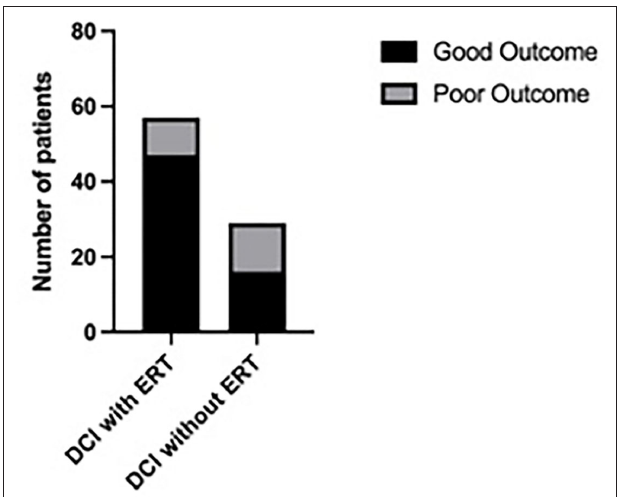
FIGURE 4 | Comparison of functional outcome of patients with DCI receiving ERT with the patient group with DCI without ERT, showing a significantly higher percentage of patients with good outcome (mRS ≤ 2) in the patient group with DCI and ERT compared to the patient group with DCI without ERT (Fisher’s Exact test, p =